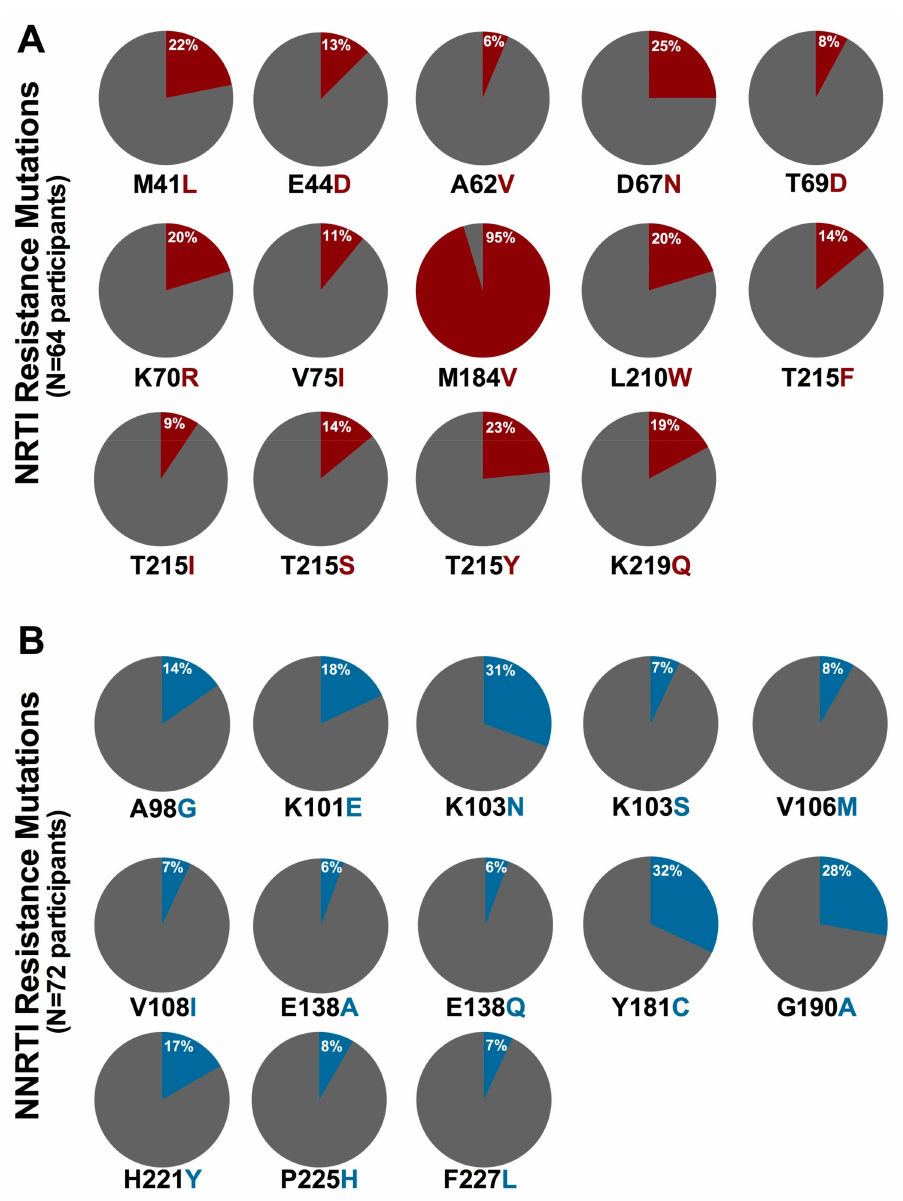
Figure 2. Prevalence of NRTI and NNRTI resistance mutations in participants with resistant genotypes: ( A ) NRTI resistance mutation (red) frequencies among 64 participants with at least one NRTI resistance mutation; and ( B ) NNRTI resistance mutation (blue) frequencies among 72 participants with at least one NNRTI resistance mutation. All mutations observed in >5% of resistant participants are